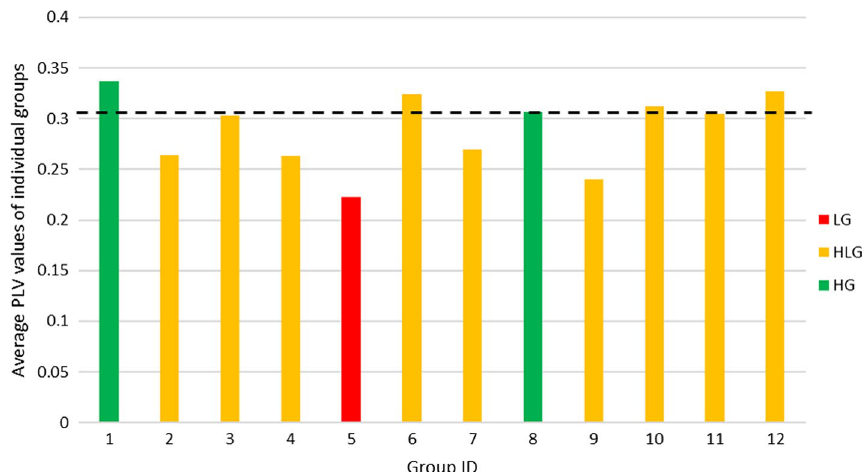
Fig. 1 The mean of PLV values of beta bands at the problem‑understanding stage